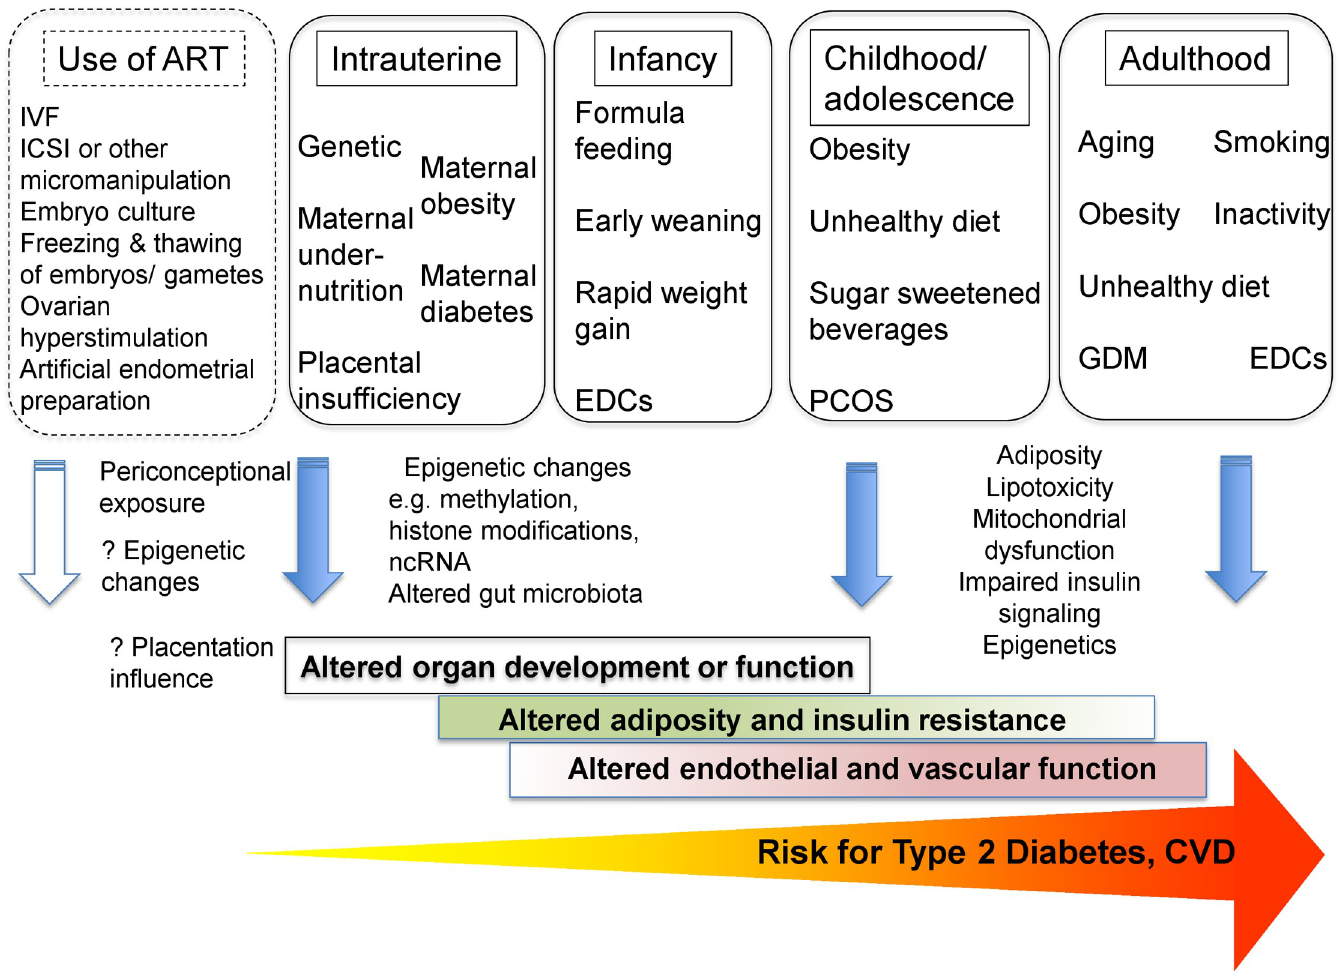
Fig 1. A DOHaD perspective on the potential relationship between ART and later risk of T2D and CVD. The putative link is highlighted by the dotted outline. ART, assisted reproduction technology; CVD, cardiovascular disease; DOHaD, Developmental Origins of Health and Disease; EDCs, endocrine-disrupting chemicals; GDM, gestational diabetes; ICSI, intracytoplasmic sperm injection; IVF, in vitro fertilization; ncRNA, noncoding RNA; PCOS, polycystic ovary syndrome; T2D, type 2 diabetes. (adapted with permission from Ma and colleagues [13 AU : PleasenotethatthecitationMaandcolleagues ð 2017 Þ hasbeenaddedtothereferenceslist : Pleasecheckandconfirmthattheaddedinformationonthelistiscorrect ; andamendifnecessary : ]).